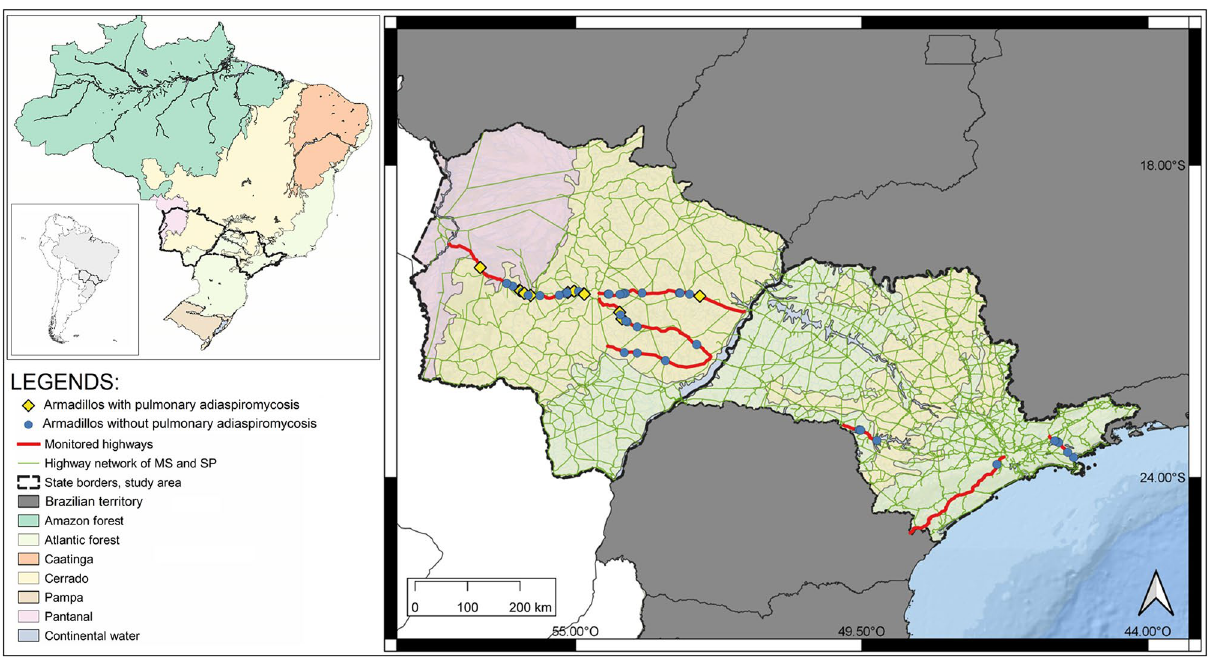
Figure 1. Geographic distribution of necropsied armadillos in roads of Mato Grosso do Sul and Sao Paulo states (Brazil) between February 2017 and February 2020. The map was created by software QGIS 3.16 (https:// qgis.